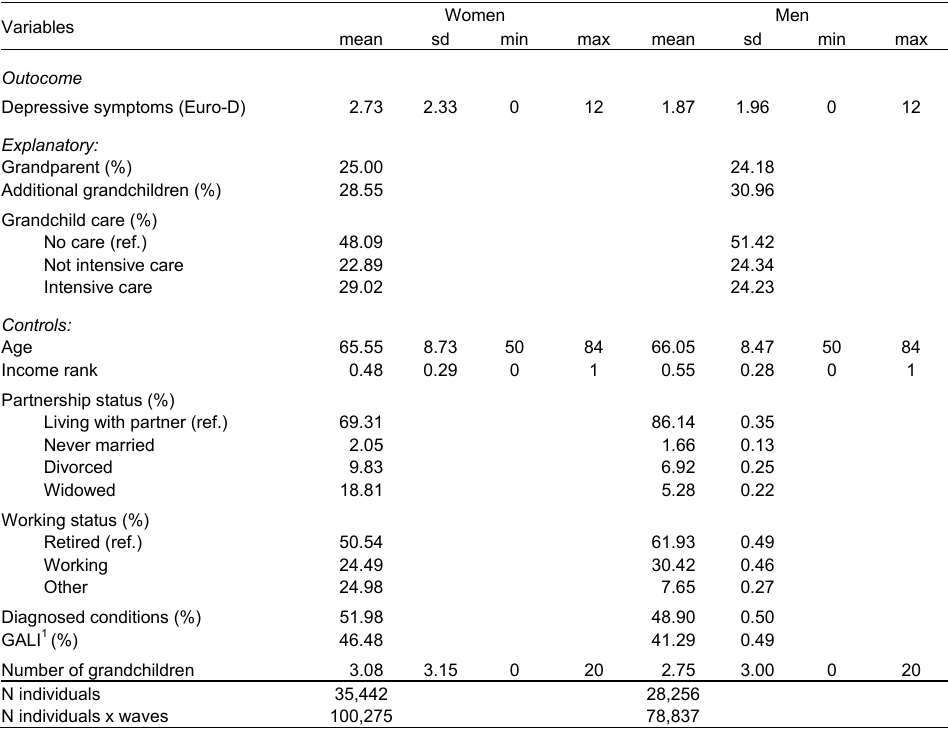
Table 1 : Descriptive statistics on all variables on the full sample (mean or percentage, standard deviation – sd–, minimum and